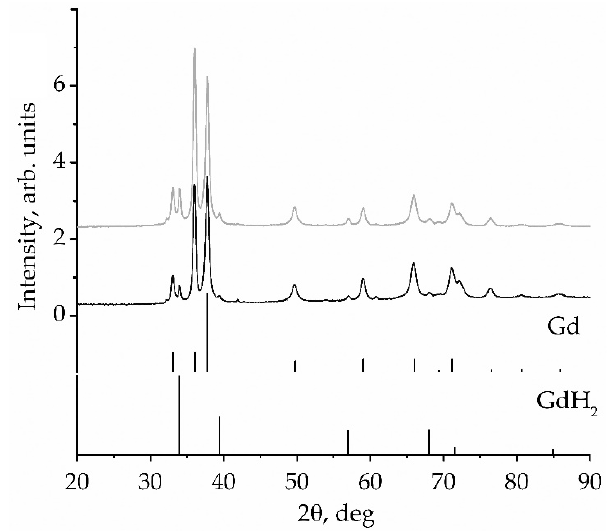
Figure 3. X-ray diffraction powder patterns of Gd powder (using Co K α radiation) with main peaks indexed. X-axis presents the irraditation angle, Y-axis presents the pattern intensity. The grey top curve corresponds to 2 h grinding, the black bottom one corresponds to 1 h grinding. The lines below the curves mark the tabulated peak positions for Gd and GdH 2, respectively. Table 1. The tabulated peak positions, intensities and Miller indexes for Gd and GdH 2